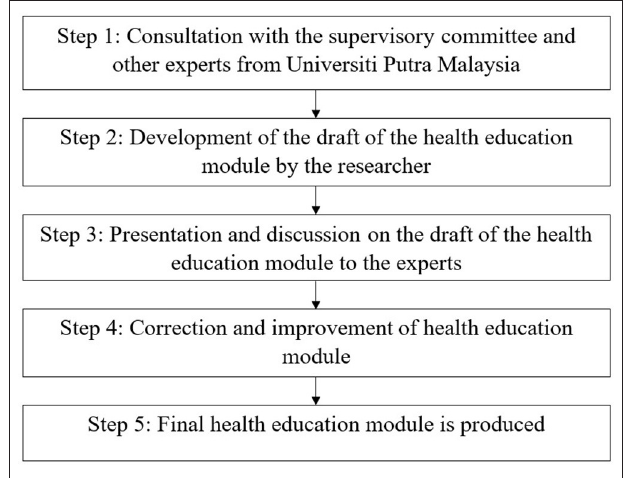
FIGURE 1 | The schematic diagram for the development of the health education module on prevention of Hand, Foot and Mouth